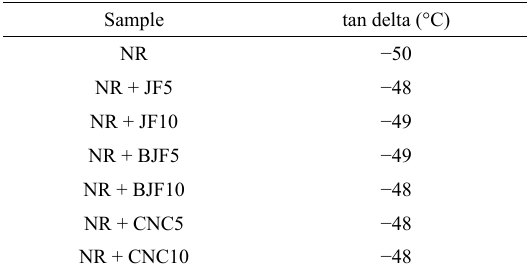
Table 5. Glass transition temperature of the NR and NR composites. Sample